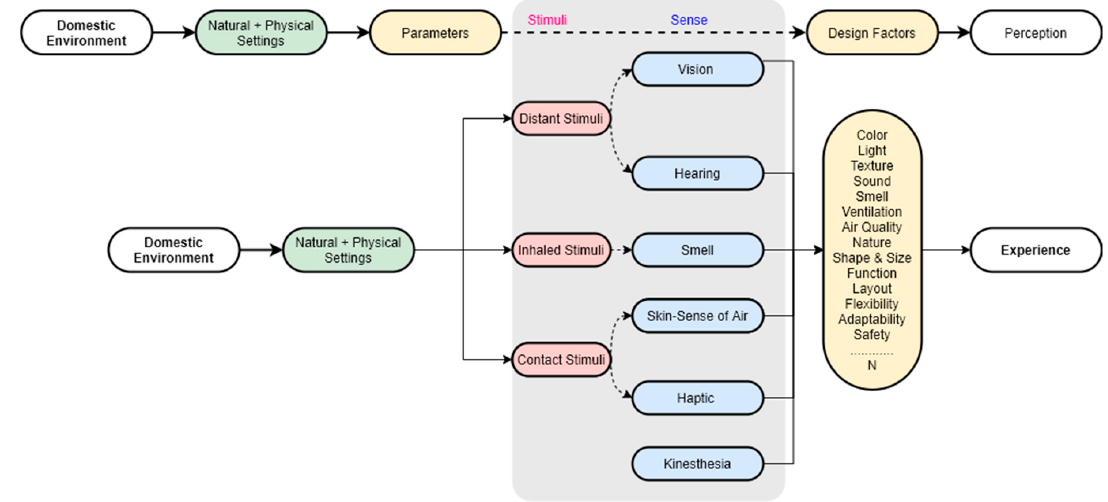
Figure 7. Domestic environmental design parameters [12–15,17,61,82].